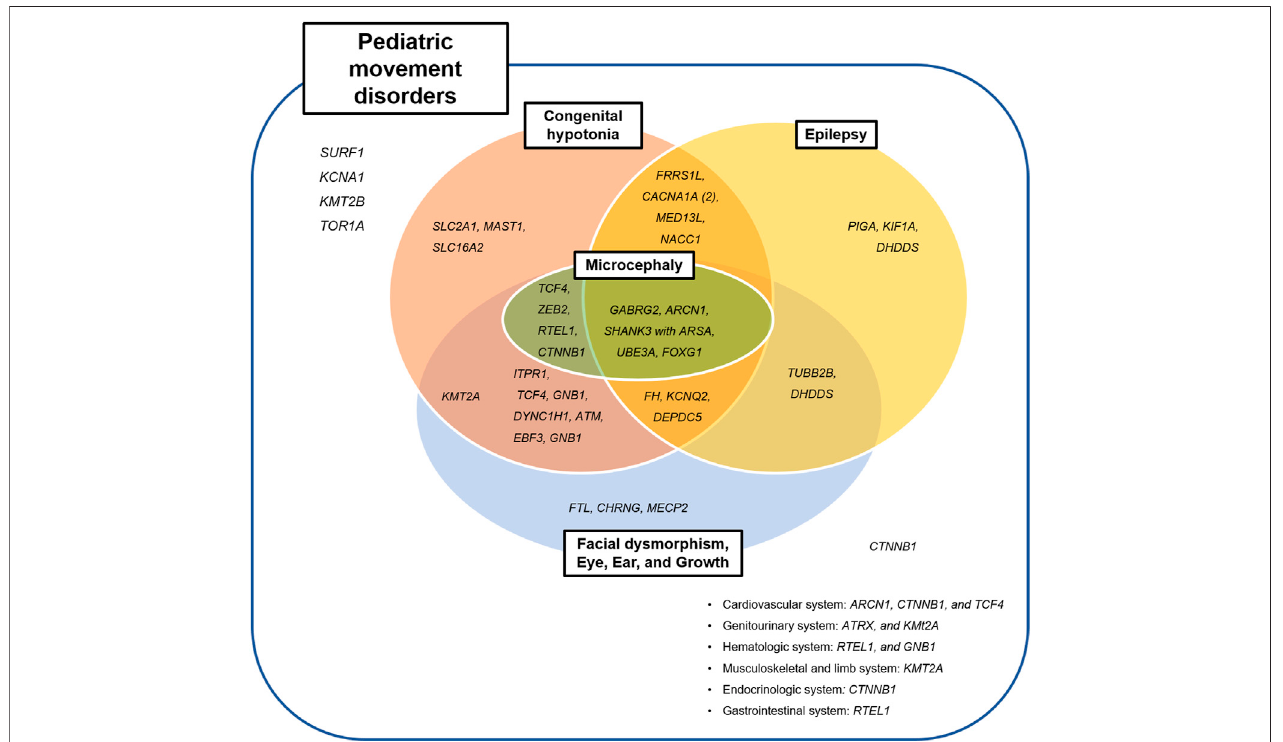
FIGURE 4 | Clinical categories of identi fi ed pathogenic